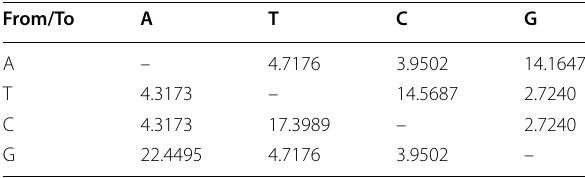
Table 3 Estimate the maximum substitutability of nucleotides according to Gamma parameters (%) of Anguilla marmorata ’s COI in Thua Thien Hue, Viet Nam From/To